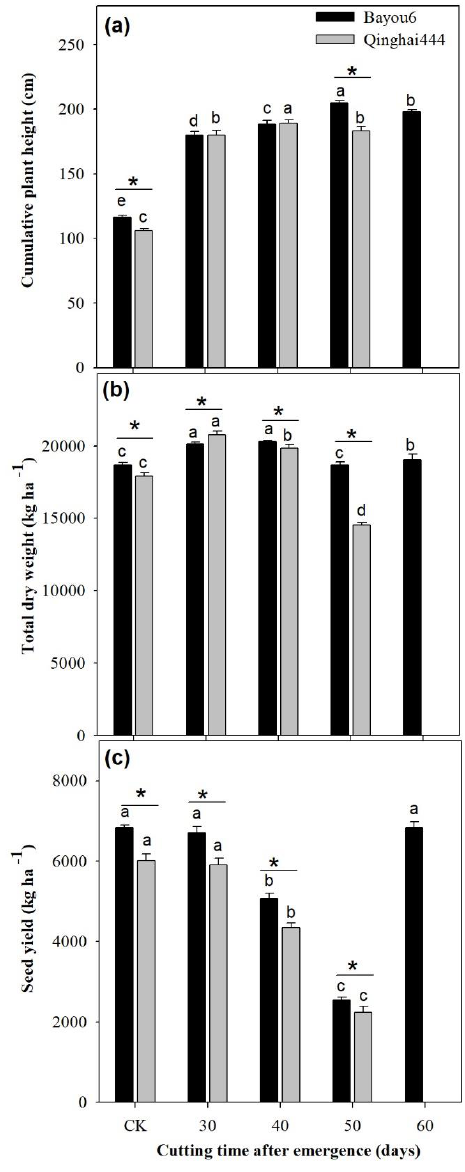
Figure 4. Cumulative plant height ( a ), total dry biomass ( b ), and seed yield ( c ) under cutting stages across whole growing season. * indicates significant di ff erences ( p < 0.05) between Bayou6 and Qinghai444 under the same treatment. Significant di ff erences are shown by di ff erent lowercase letters under varying cutting stages for each cultivar at p < 0.05. Data are means ± SE ( n =